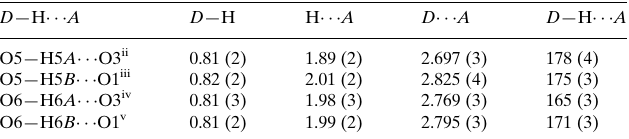
Hydrogen-bond geometry (A˚ , (cid:3)